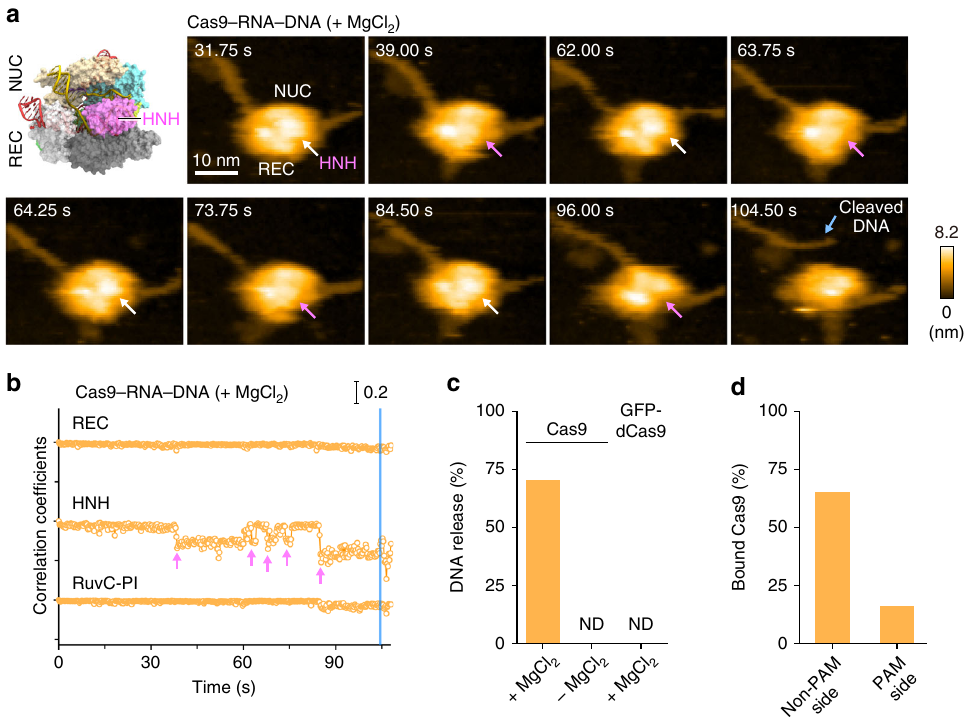
Fig. 3 HS-AFM observations of DNA cleavage by Cas9 – RNA. a Sequential HS-AFM images of Cas9 – RNA – DNA in the presence of MgCl 2 . The HNH domains in the inactive (high-height) and active (low-height) states are indicated by white and magenta arrows, respectively. The scale bar is 10 nm. b Time courses of correlation coef fi cients for the individual domains between the sequential HS-AFM images of Cas9 – RNA – DNA in the presence of MgCl 2 . The HNH domain fl uctuations are indicated by magenta arrows. The release of the cleavage product is indicated by a blue line. c Rates of the cleavage product release from Cas9 – RNA in the presence ( n = 361) and absence ( n = 36) of MgCl 2 , and from GFP-dCas9 – RNA ( n = 37). ND, not detected. d Binding position of Cas9 – RNA after the product release ( n =